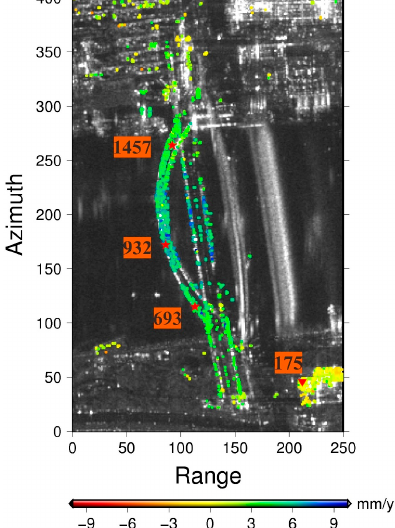
Figure 6. Linear deformation rates (in the line of sight (LOS) direction) of PSs. The labeled numbers are the IDs of chosen PSs. Red stars and the inverted triangle indicate the monitoring PSs (No. 693, 932, and 1457) and the reference PS (No. 175), respectively.